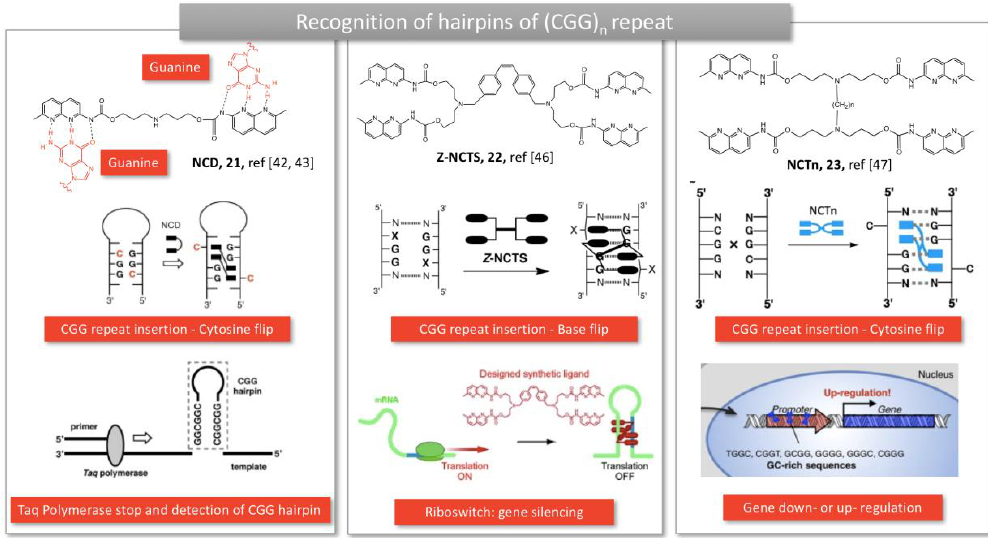
Figure 5. Molecular tweezers developed to detect CGG repeat causing hairpins and their pharmaceutical pharmaceutical applications. Adapted from [42,46,47]. applications. Adapted from